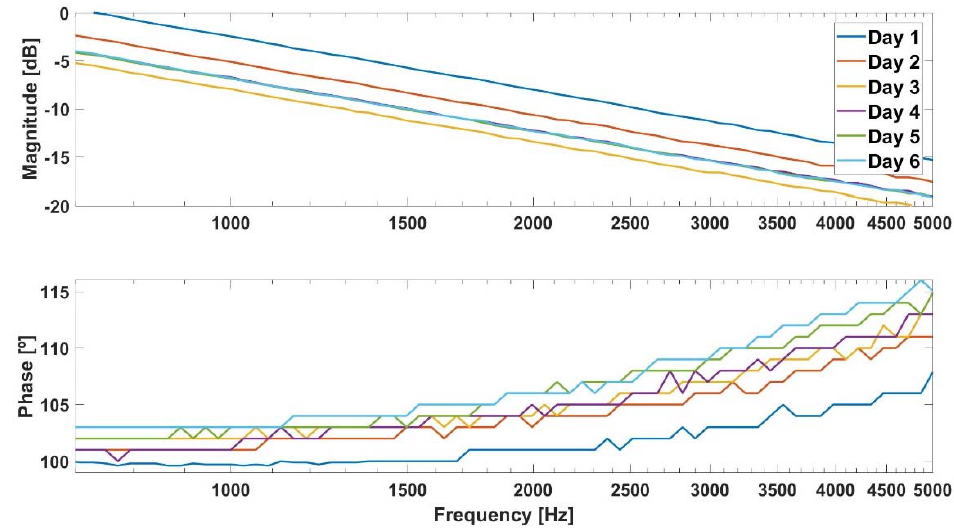
Figure A6. Area of interest in the Bode diagram from Figure 4.